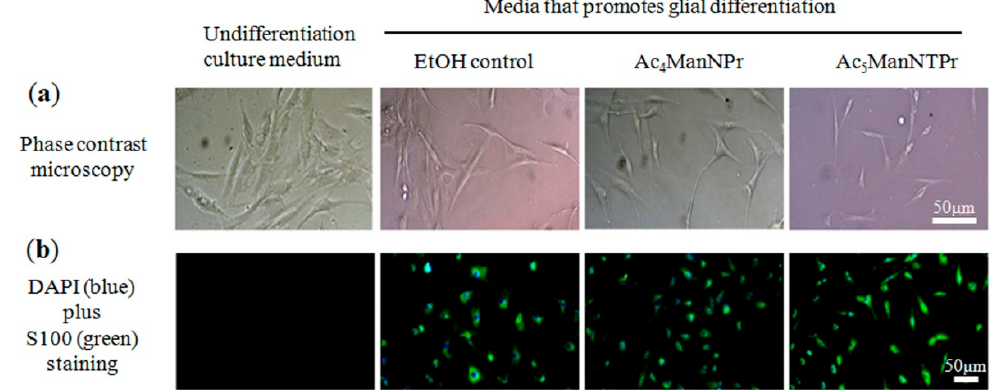
Figure 8. Schwann cell (SC) differentiation of hASC. ( a ) Morphological and physiological changes following ASC glial differentiation. hASCs showed a flattened fibroblast-like morphology that adopted a spindle elongated, SC-like morphology after incubation in differentiation medium. ( b ) Immunofluorescence staining indicated differentiated hASCs expressed the S100 protein, a Schwann cell marker. Scale bars = 50 μ m.